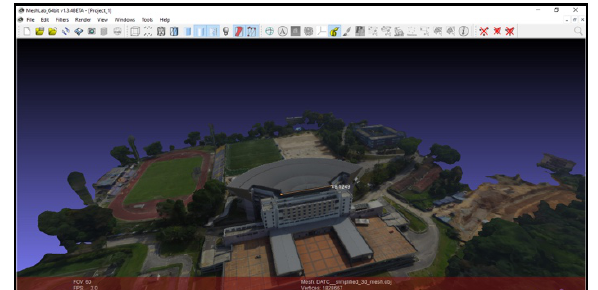
Figure 3. Measuring the length of the building.